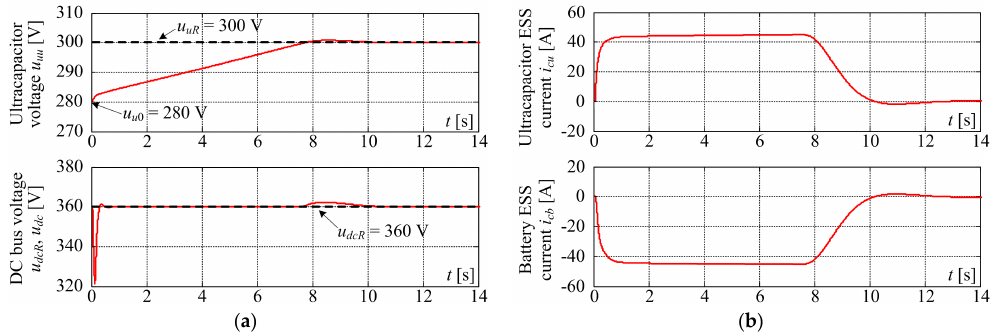
Figure 10. Simulation responses of ultracapacitor auxiliary voltage control system: ultracapacitor and DC bus voltage traces ( a ) and battery/ultracapacitor ESS current responses ( b ).